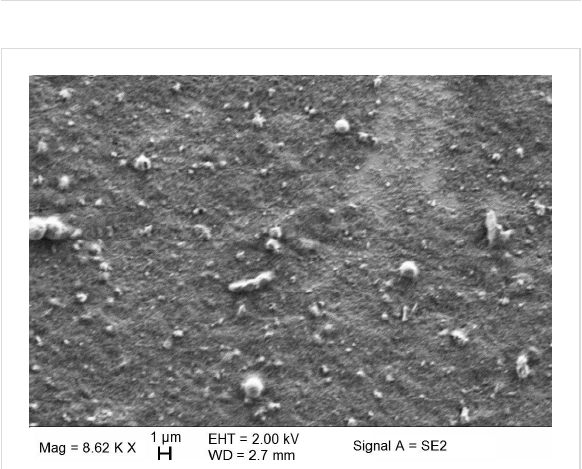
Figure 14: Field enhancement ratio for an array of Ag nanoantenna structures with tip-to-edge length of 370 nm, thickness of 50 nm and gap size of 60 nm calculated for excitation at 532 nm. The polarization direction of the electrical field is horizontal.